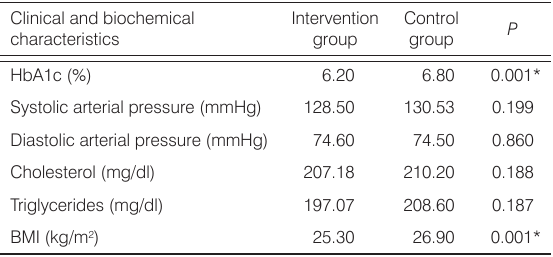
Table 3. Clinical and biochemical characteristics of the participants by groups after intervention.